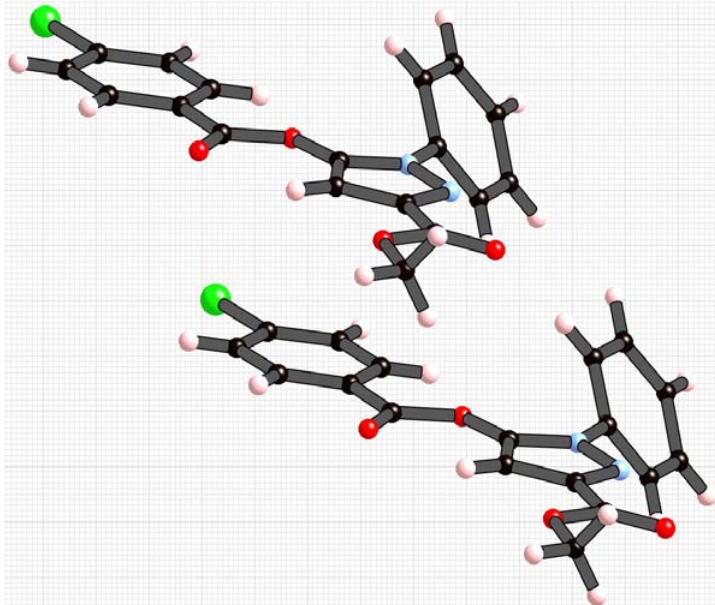
Figure 3. π -Stacking of benzoyl-diazene moieties, extending along the xy diagonal.